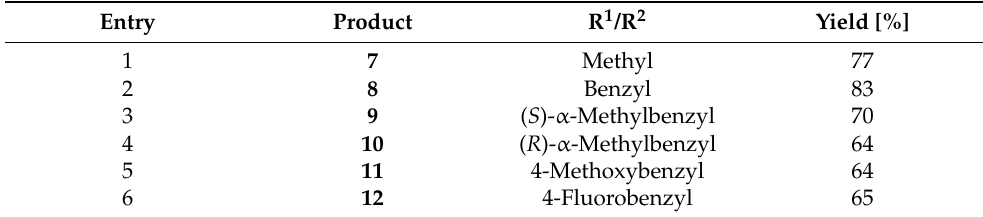
Table 1. Synthesis of aminoalcohols 7 – 12 via Schiff